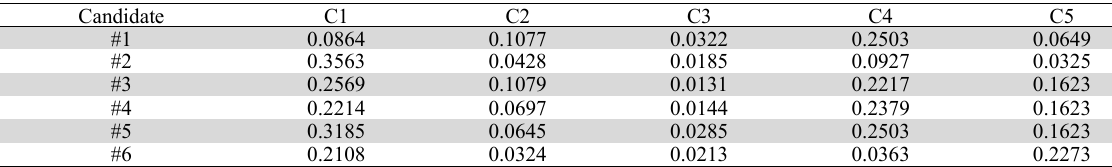
New criteria has extracted based on PCA Candidate